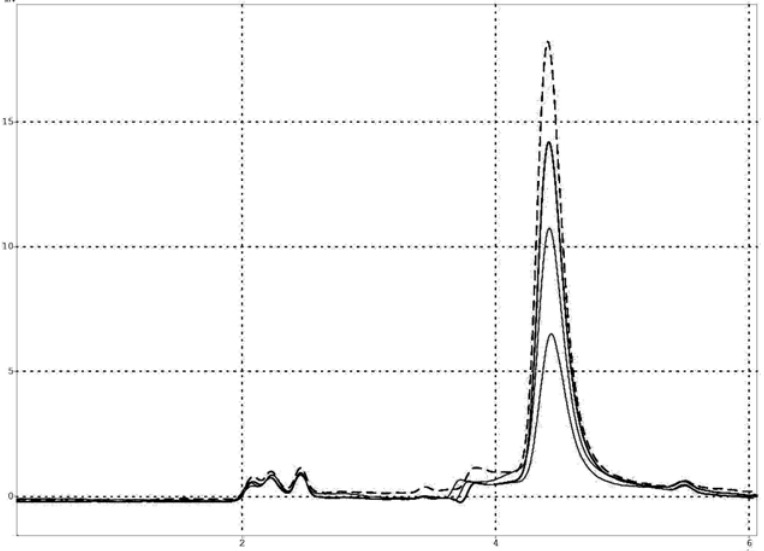
Figure 1. HPLC elution profiles for oxidation of aromatic aldehydes with salivary ALDH, recorded with fluorimetric detector at 360 nm, with excitation at 315 nm. Reaction time was 5 (lowest curve), 10, 15 and 20 minutes